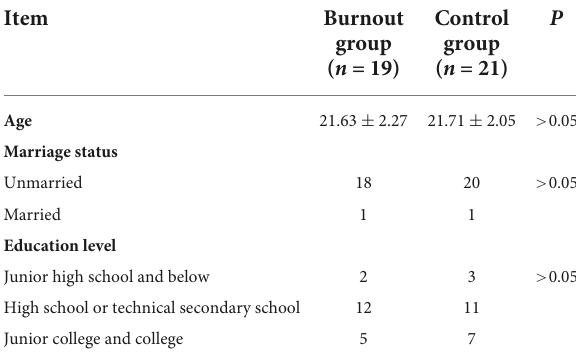
TABLE 3 General information of ERP participants ( n = 40).